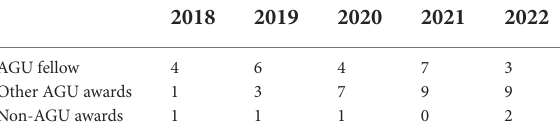
TABLE 1 Number of nomination packages submitted by the